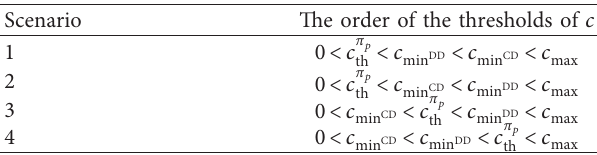
Table 3: Four scenarios and the corresponding order of the thresholds of c